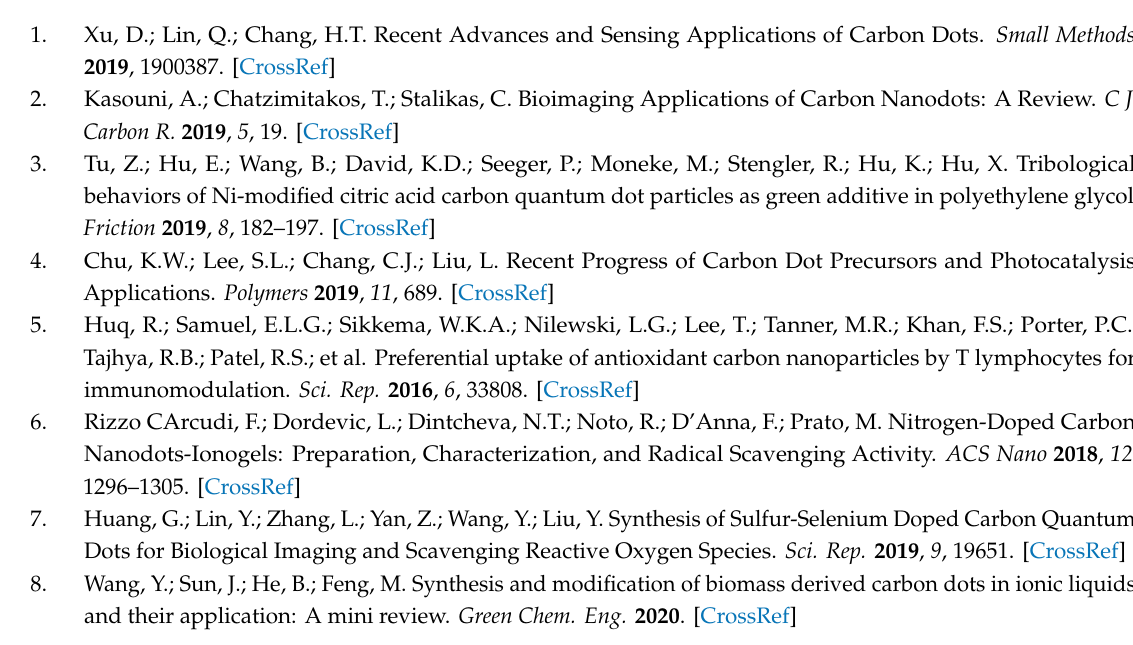
Figure S1: HRTEM image of P2CDs showing uniform dispersity of carbon dots (small dark spots) at 100 nm resolution; Figure S2. Urbach energy estimation for GCDs; Figure S3. Urbach energy estimation for TCDs; Figure S4. Urbach energy estimation for P1CDs; Figure S5. Urbach energy estimation for P2CDs; Figure S6. Excitation and emission spectra of the synthetized carbon dots. The spectra were vertically shifted for the sake of clarity; Table S1. Some key tribological properties of the mineal ISO 68 oil (Repsol